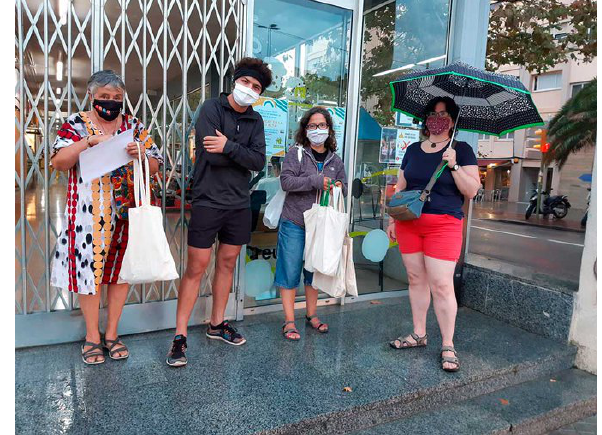
Figure 5. Some volunteers after one acquisition